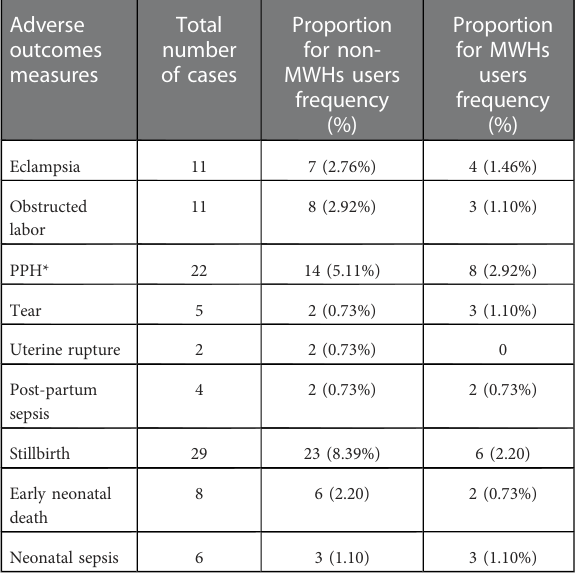
TABLE 2 Adverse maternal and birth outcomes of the respondents on maternal waiting home utilization, east gojjam, 2017. Adverse